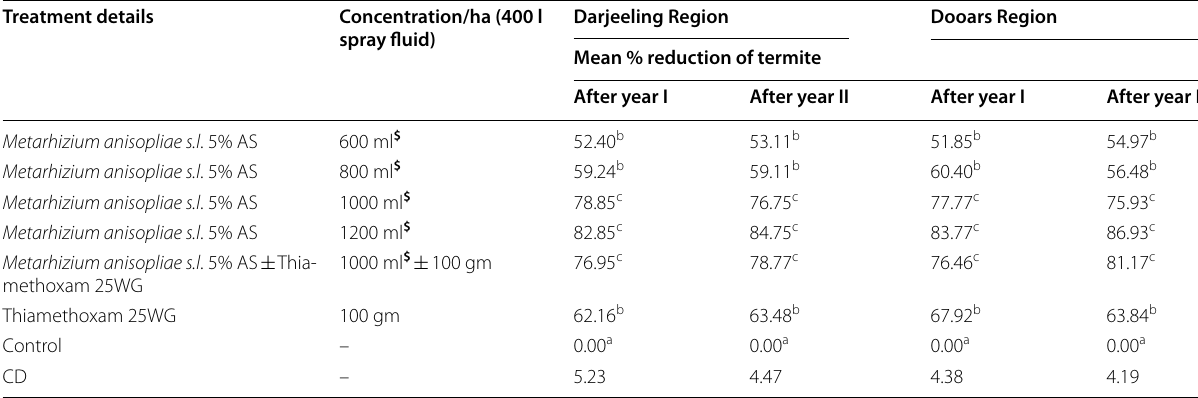
Mean of five replications, differences among the tested doses are grouped in same column with small letters and the identical letters do not differ significantly at P 0.05 according to Tukey’s multiple comparison test. $ Containing 2 =